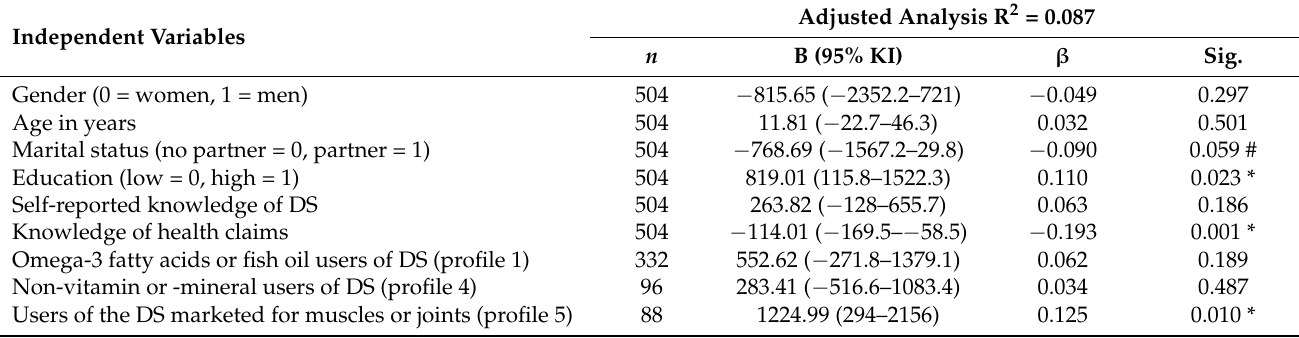
Table 6. Adjusted linear regression analysis of the association between the money spent on DS in the last year (dependent variable) and significant independent variables from the unadjusted analyses in addition to age and